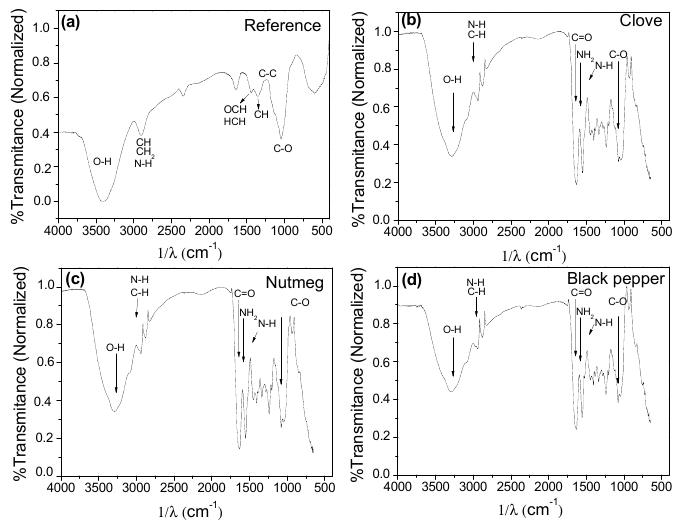
Figure 10. FTIR spectra of biocomposite films. ( a ) Reference (without oleoresin); ( b ) with clove oleoresin; ( c ) with nutmeg oleoresin and ( d ) with black pepper oleoresin.